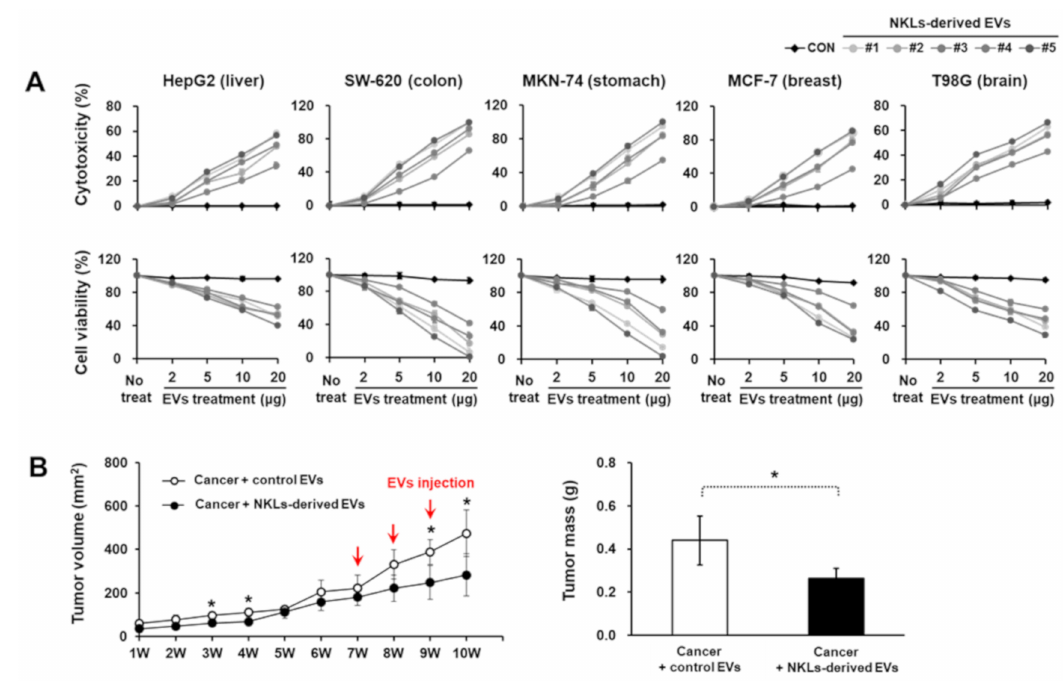
Figure 3. Cytotoxic potential of isolated EVs against cancer cell lines and cancer animal model. ( A ) Isolated individual EVs were used to treat 5 cancer cell lines from di ff erent tissues; cytotoxicity of isolated EVs against cancer cells was observed, and cell viability of cancer cells against isolated EVs was measured. Experiments were performed in triplicate. Significant di ff erences between untreated cancer cells and EV-treated cancer cells were determined via ANOVA. ( B ) The volume of tumor and tumor mass after administration of vehicle (PBS) and NKL-derived EVs in MCF-7-cell-injected female athymic nude mice. The tumor volume was monitored every week for 10 weeks ( n = 4 for each group), and tumor mass was measured at the end of the animal study. Significant di ff erences between groups were determined via ANOVA, with p -values indicated as * p <